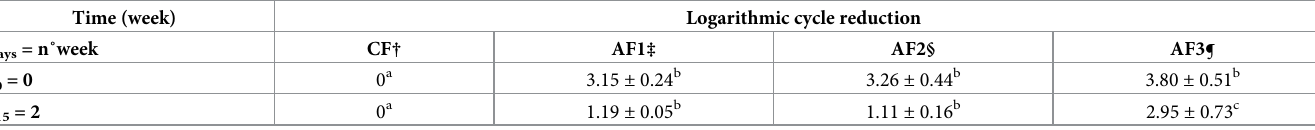
Table 5. Evaluation of the antimicrobial capacity of the films.